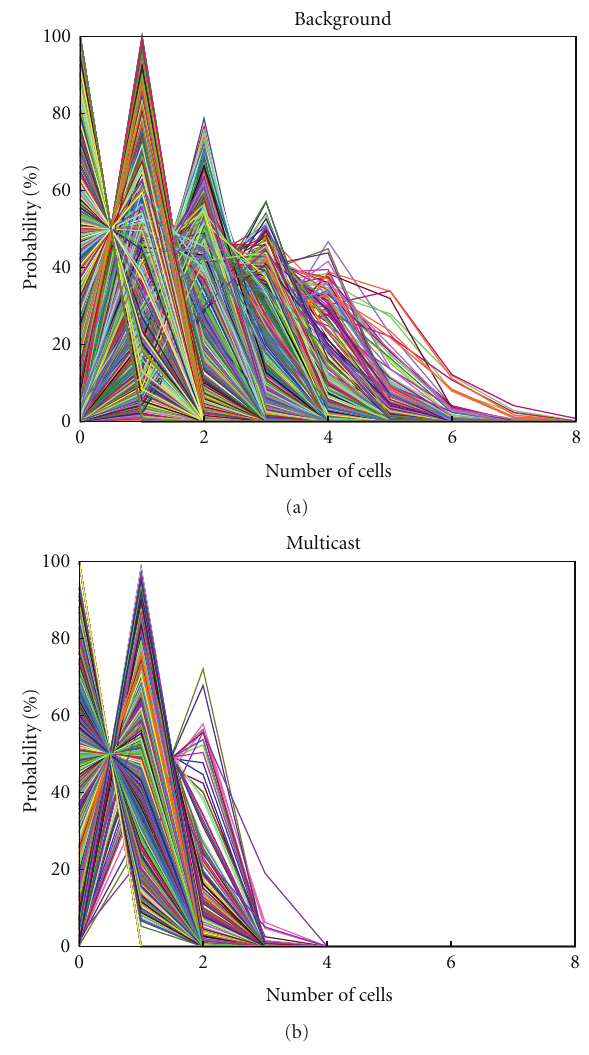
Figure 9: PDF for number of queued cells per tra ffi c flow per router for Germany50 topology. (a) for background tra ffi c. (b) for multicast tra ffi c.